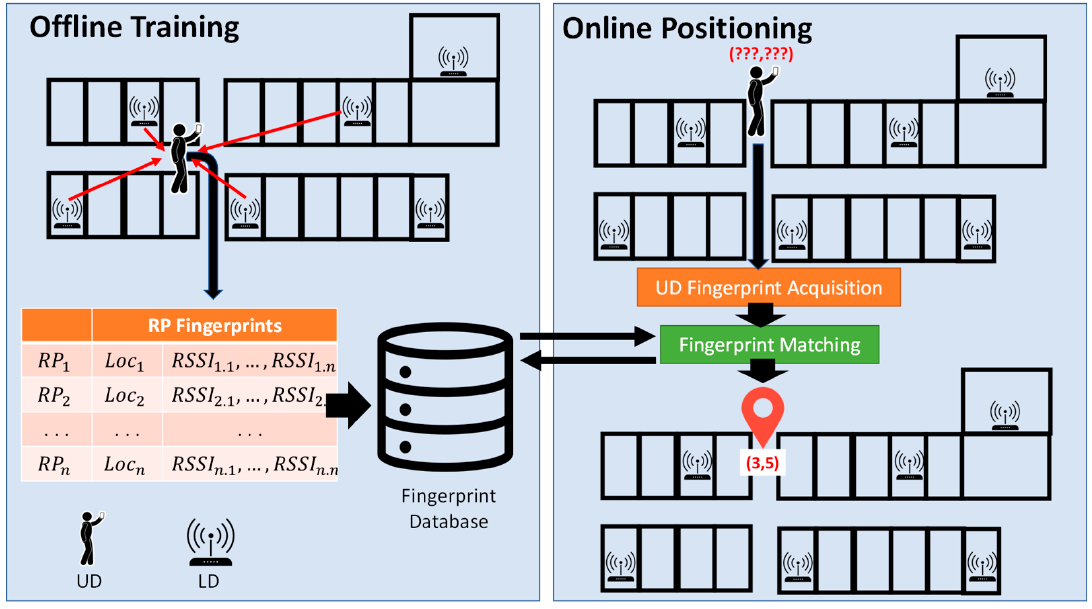
Figure 3. Illustration of the fingerprint-based IL method.